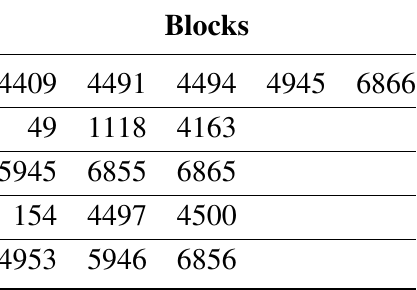
Table 2. The computed results for the mushroom dataset (left) and the pumsb dataset (right), where the blocks of single items are omitted in the left table and the blocks of at most two items are omitted in the right table. Each line corresponds to one block.